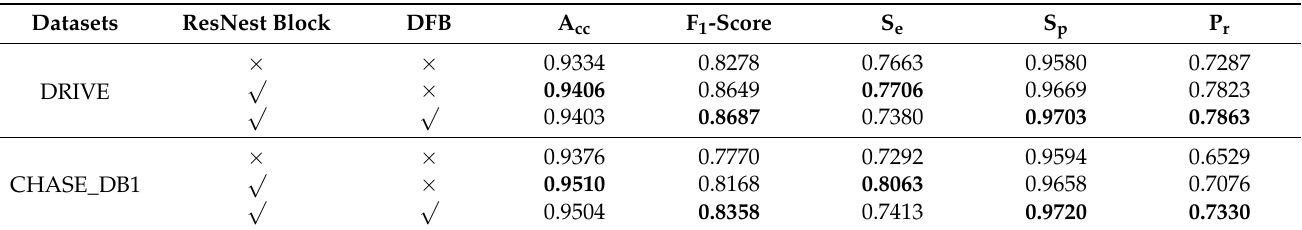
Table 4. Results of ablation experiments.